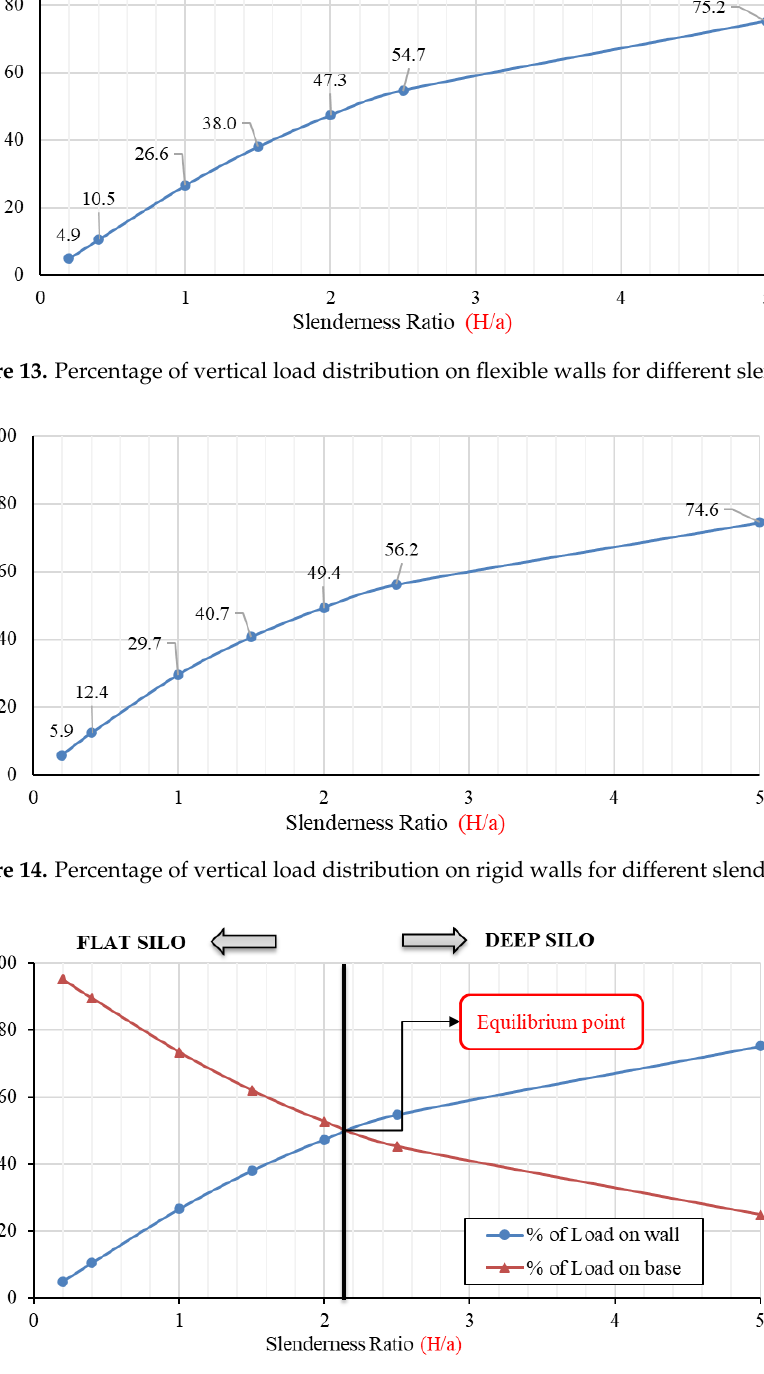
Figure 15. Vertical load distributions inside flexible wall silos for various slenderness ratios.